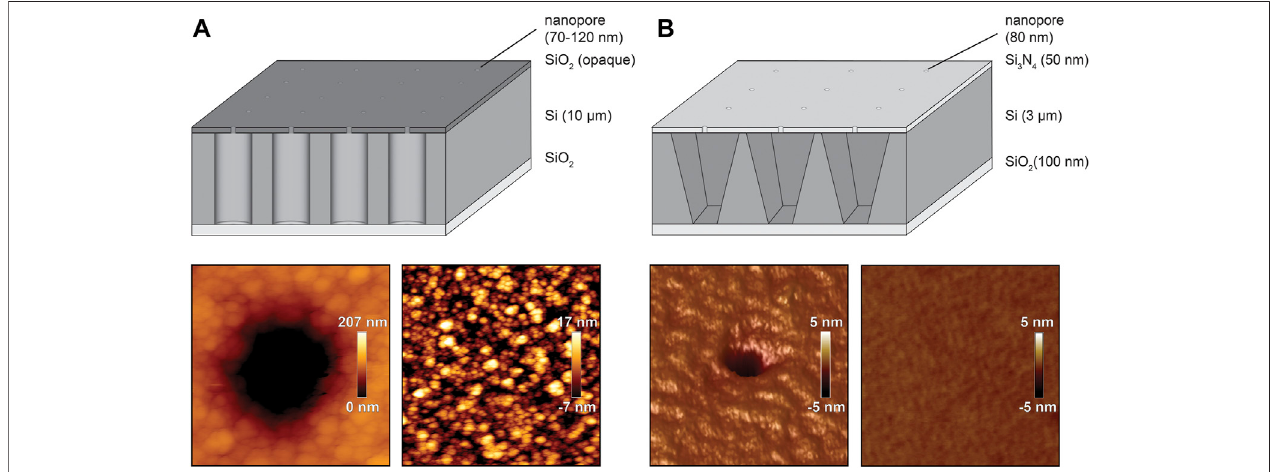
FIGURE 3 | Comparison of different silicon chip architectures. Schematic illustration of the silicon chips (dimensions are not drawn in scale) published by Urban et al. (2014) and Diederichs et al. (2018) including AFM roughness analysis of the vicinity and in distance of the nanopore (Urban et al., 2014; Reprinted (adpated) with permission form Diederichs et al., 2018. Copyright (2021) American Chemical Society). (A) , Silicon-on-insulator chip featuring cylindrical cavities of 6 – 15 fL and the including AFM images. (B) , Transparent silicon chip featuring an inverted pyramidal shape of 50 fL.